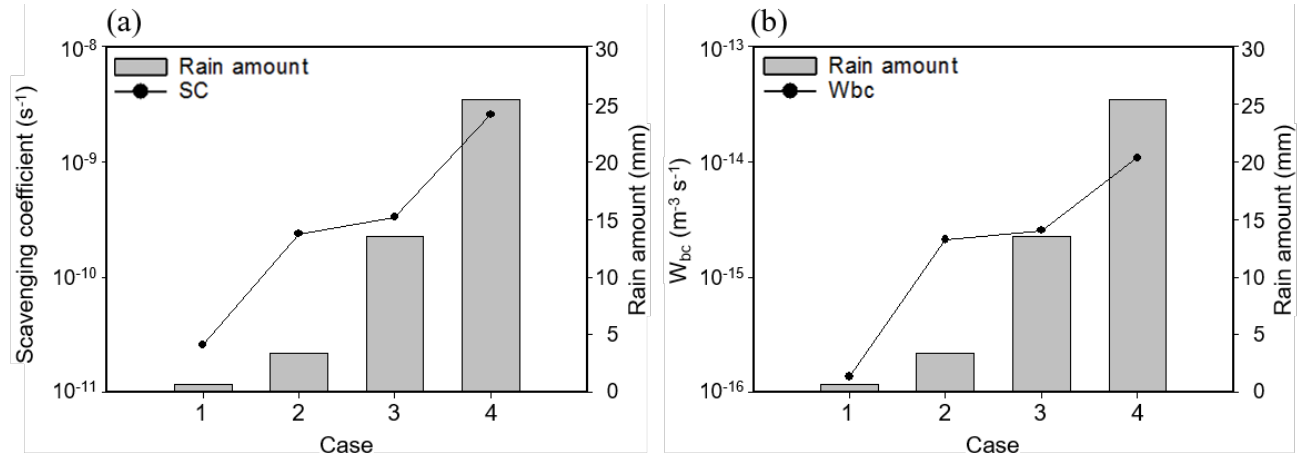
Figure 7. Comparison of the ( a ) mean scavenging coefficient and ( b ) mean below-cloud scavenging rate and rain amount in Cases 1 to 4.